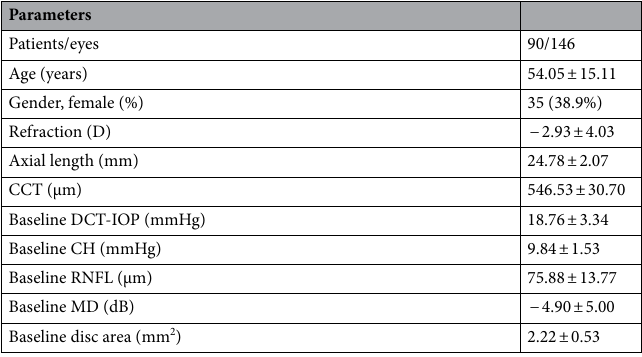
Table 1. The demographics and baseline visual field, optic nerve head (ONH), retinal nerve fiber layer (RNFL), and corneal hysteresis (CH) measurements of glaucoma patients (Mean ± SD).